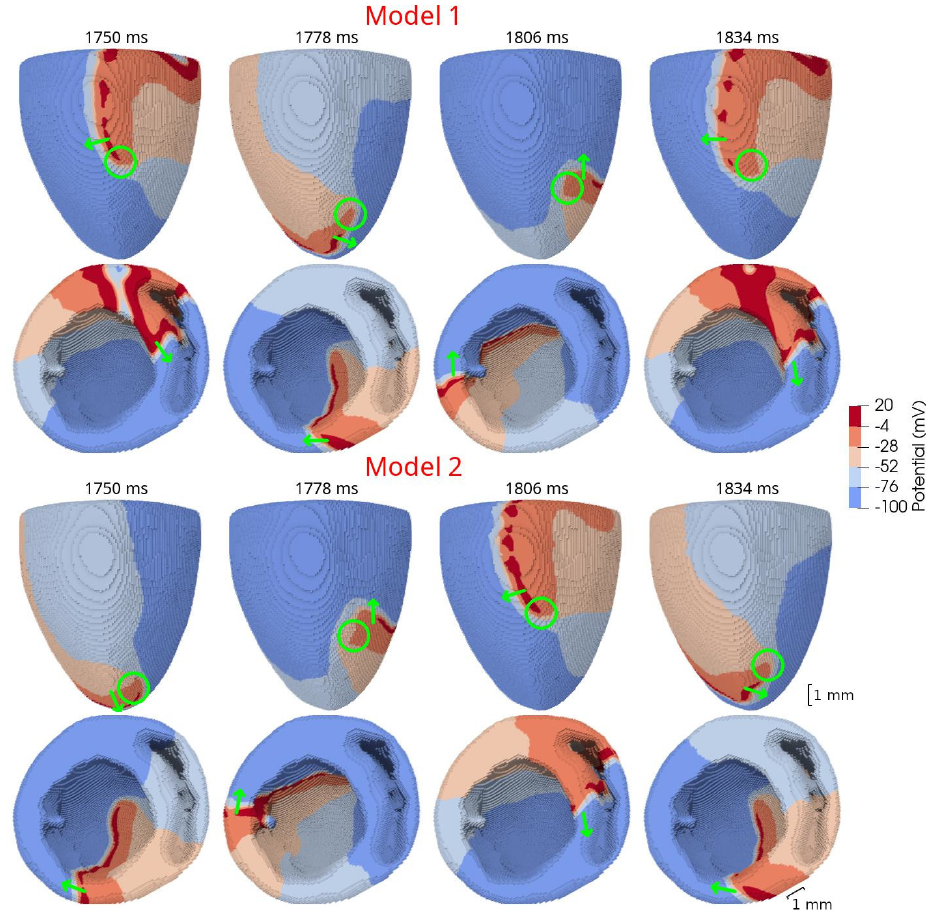
Figure 8. Rotating scroll waves in an anatomical model of rat ventricles with Cellular Models 1 and 2. The top row shows the ventricles from the side of the RV free wall and the LV anterior wall. The bottom row shows the view from the base. A 1 mm spatial scale bar is shown at the bottom right. The color scale for transmembrane potential is given on the middle right. Green circles point to the spiral wave tip and green arrows show the wave propagation